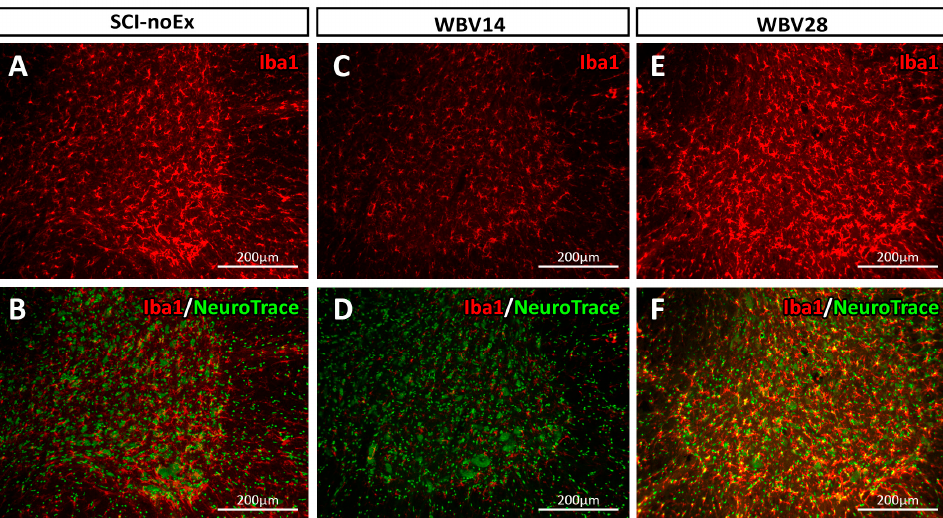
Figure 5. Immunostaining of microglia/macrophages in the ventral horn in a transverse section of the lumbar-spinal-cord L2 segment using rabbit anti-Iba1 and sheep anti-rabbit Cy3 conjugated IgG antibodies at 12 weeks after SCI. The Iba1 immunostaining visualized microglia/macrophages in their characteristic star- or irregular round-shaped cell morphologies with their cell processes, which extended in all directions from the cell body. ( A ) SCI-noEx, ( C ) WBV14, ( E ) WBV28. Counterstaining with NeuroTrace 500/525 green fluorescent Nissl staining unequivocally showed the large neuronal cell bodies of the ventral horn α -motoneurons ( B ) SCI-noEx, ( D ) WBV14, and ( F ) WBV28.